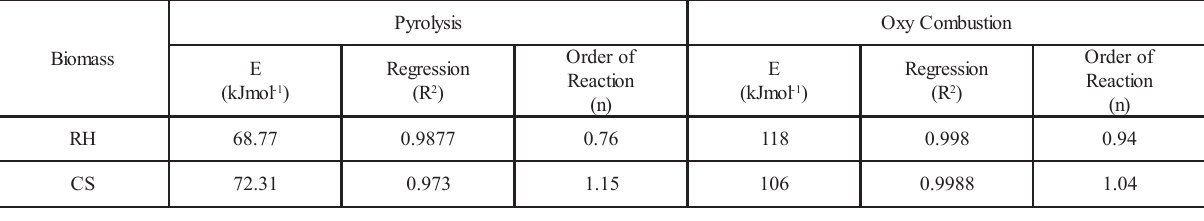
TABLE 5. APPARENT ACTIVATION ENERGY AND ORDER OF REACTION UNDER INERT AND OXY COMBUSTION